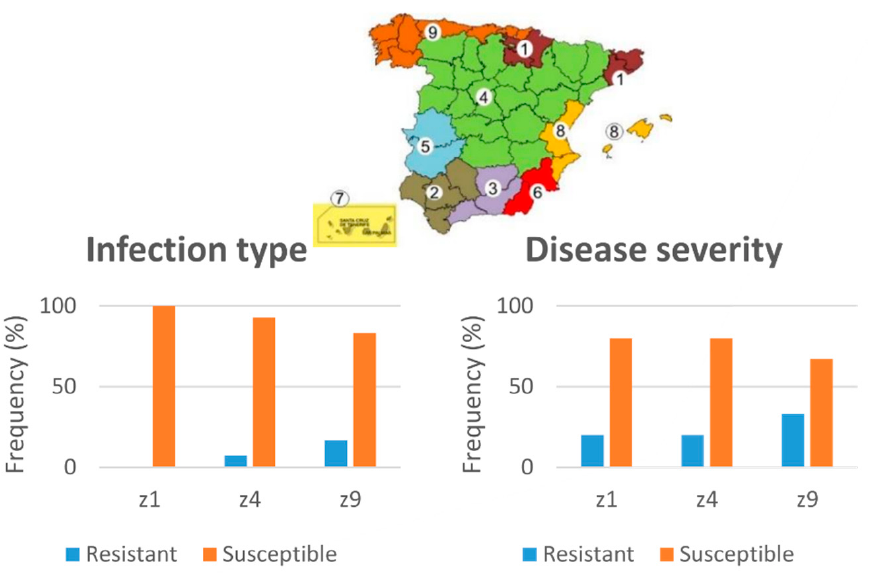
Figure 6. Frequency of resistant landraces to yellow rust at seedling stage in the agroecological zones of Spain Z1, Z4, and Z9 defined by [25].